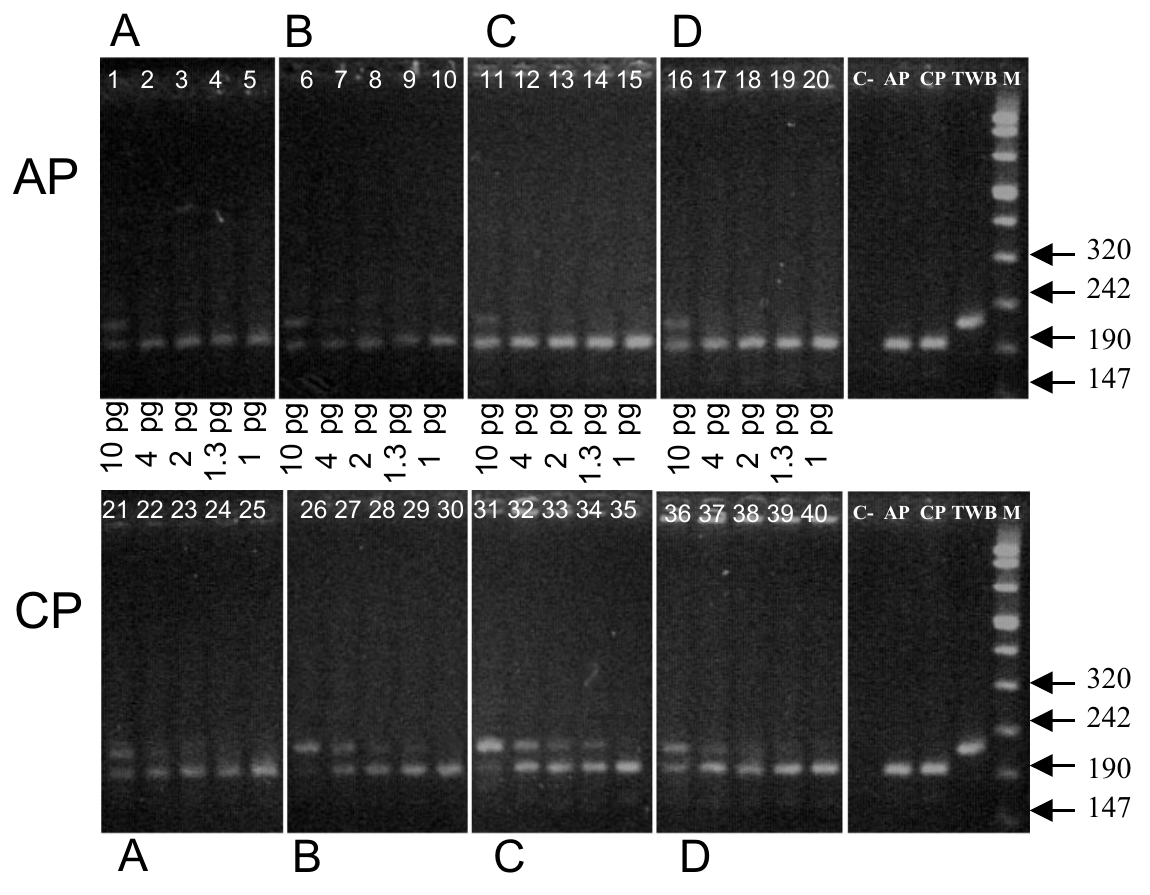
Fig. 1. Gel electrophoresis of the competitive PCR amplification products obtained with the first series of the DNA extractions. The DNA, obtained with the four extraction techniques from plants infected with AP-phytoplasma (top: method A, lanes 1–5; B, lanes 6–10; C, lanes 11–15; D, lanes 16–20) and CP-phytoplasma (bottom: method A, lanes 1–5; B, lanes 6–10; C, lanes 11–15; D, lanes 16–20) was amplified in the presence of serial dilutions of competitor DNA. The dilutions of competitor DNA are shown and expressed as pg. Lane C-: negative control. Lanes AP, CP, TWB: positive control for AP, CP and TWB phytoplasma DNA. Lane M: molecular size Marker VIII (Roche diagnos- tic, Mannheim,